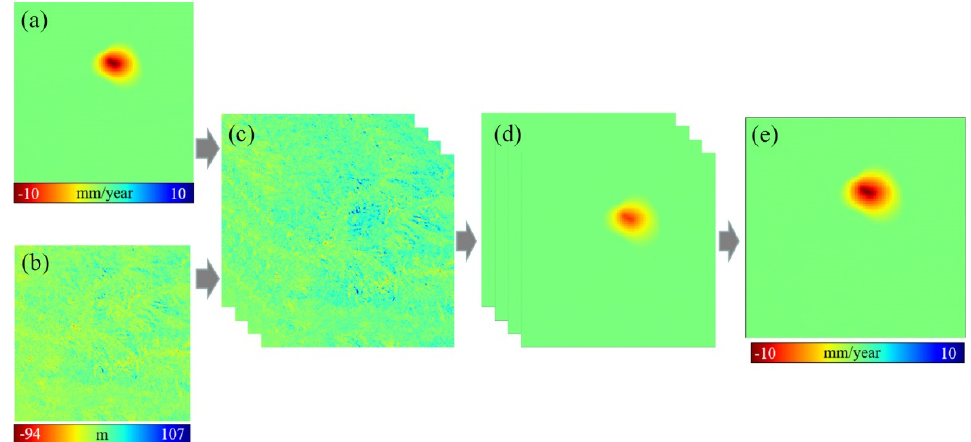
Figure 4. Pseudo-combination SBAS deformation calculation. ( a ) Simulated deformation data; ( b ) simulated height data; ( c ) simulated differential interferogram; ( d ) pseudo-combination of interferogram; and ( e ) deformation calculation result.